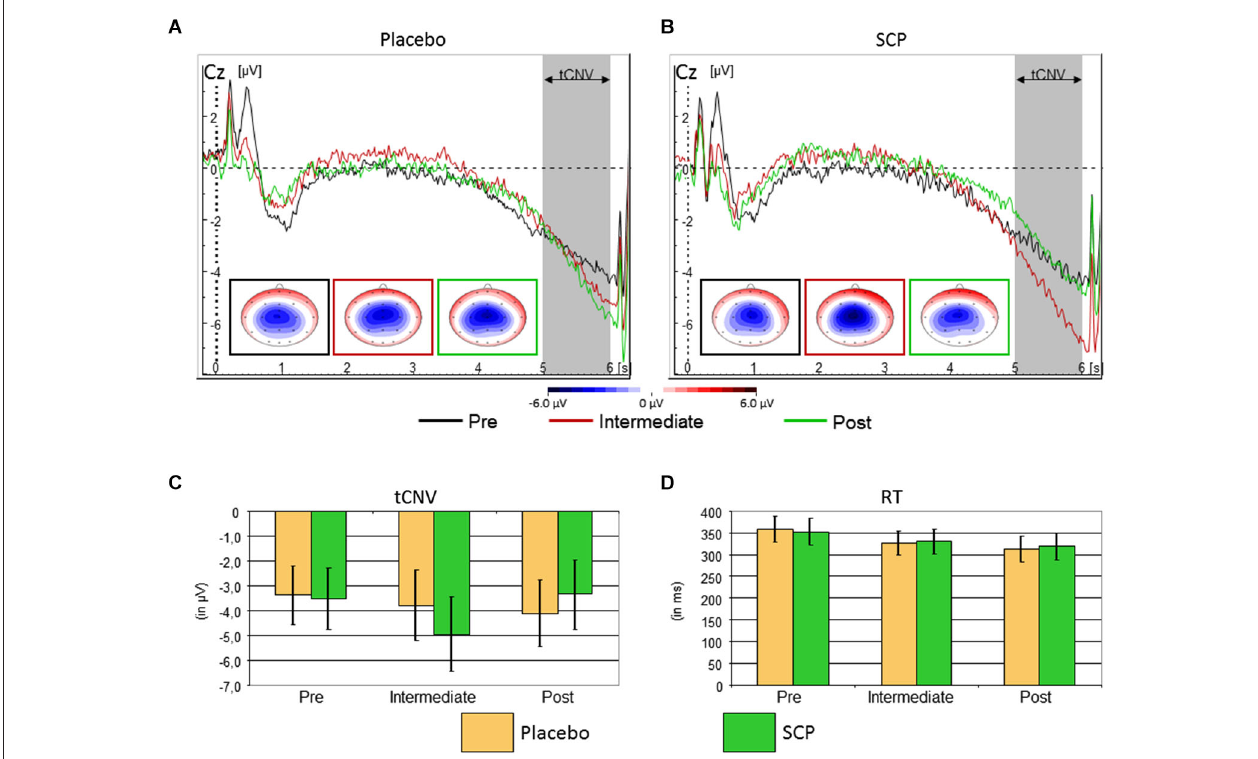
exhibits as a tendency a steady increase in amplitude from pre-training to post-training assessment, whilst the SCP training group shows an inverted U-like shift with a significant and homogenous maximum at the Intermediate assessment (C) . Response speed became faster in later assessments in both training groups (D) CPT-performance in the neurophysiological test session was characterized by a generally high accuracy with on average less than 1.5% of omission and commission error rates in both SCP and Placebo training